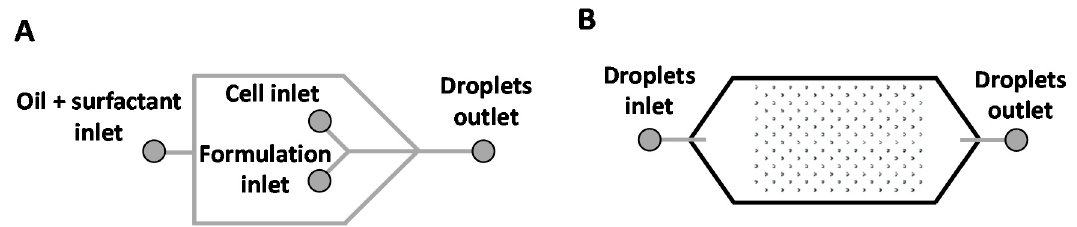
Figure 8. Schematic representation of the design of the microfluidic devices used in this work as microdroplet generators ( A ) and microdroplet reservoirs ( B ).